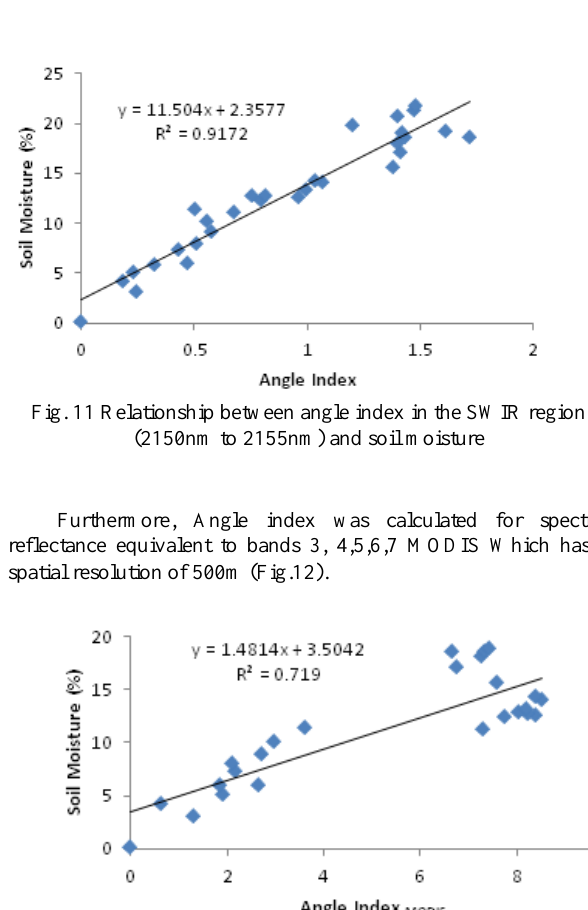
Fig. 12 Relationship between angle index bands 3, 4,5,6,7 MODIS and soil moisture Finally, new spectral angle index was calculated only for bands 6 (1640nm) and 7(2130nm) MODIS. Fig. 13 shows that there is a good relationship between MODIS angle index and soil moisture (%).